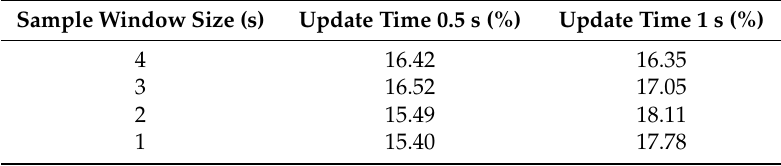
Table 3. Average false positive percentage of the test results per minute for FOG index, across all the subjects for the anterior–posterior axis of shank